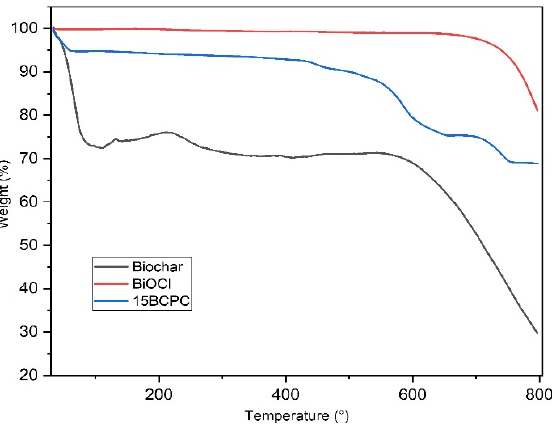
Figure 5. The TGA curves of biochar, BiOCl, and 15BCPC under a nitrogen atmosphere (heating at a rate of 10 °C/min).